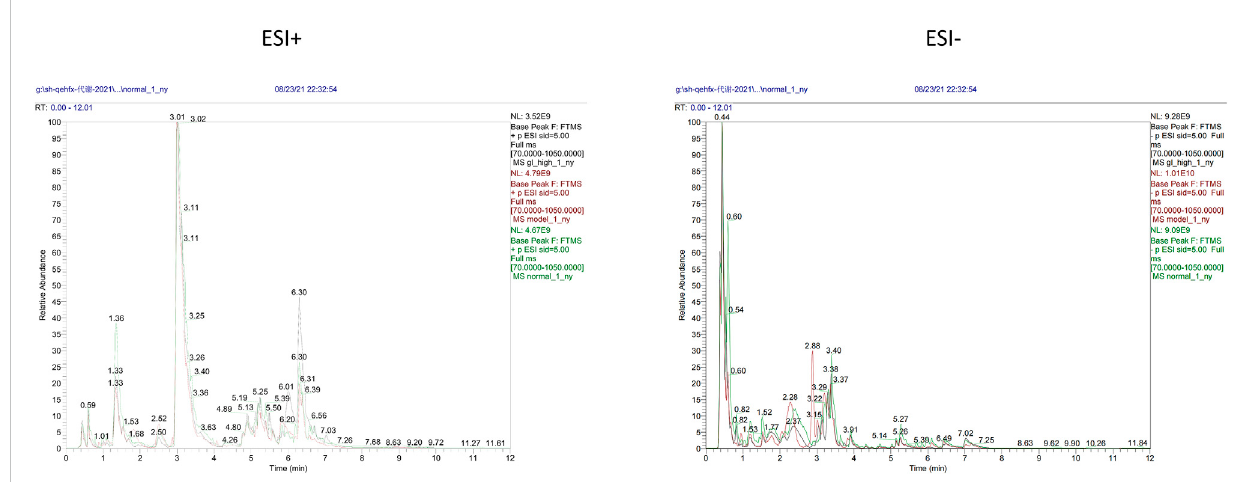
FIGURE 3 Representative BPC of rat liver tissue in positive and negative ion mode for each